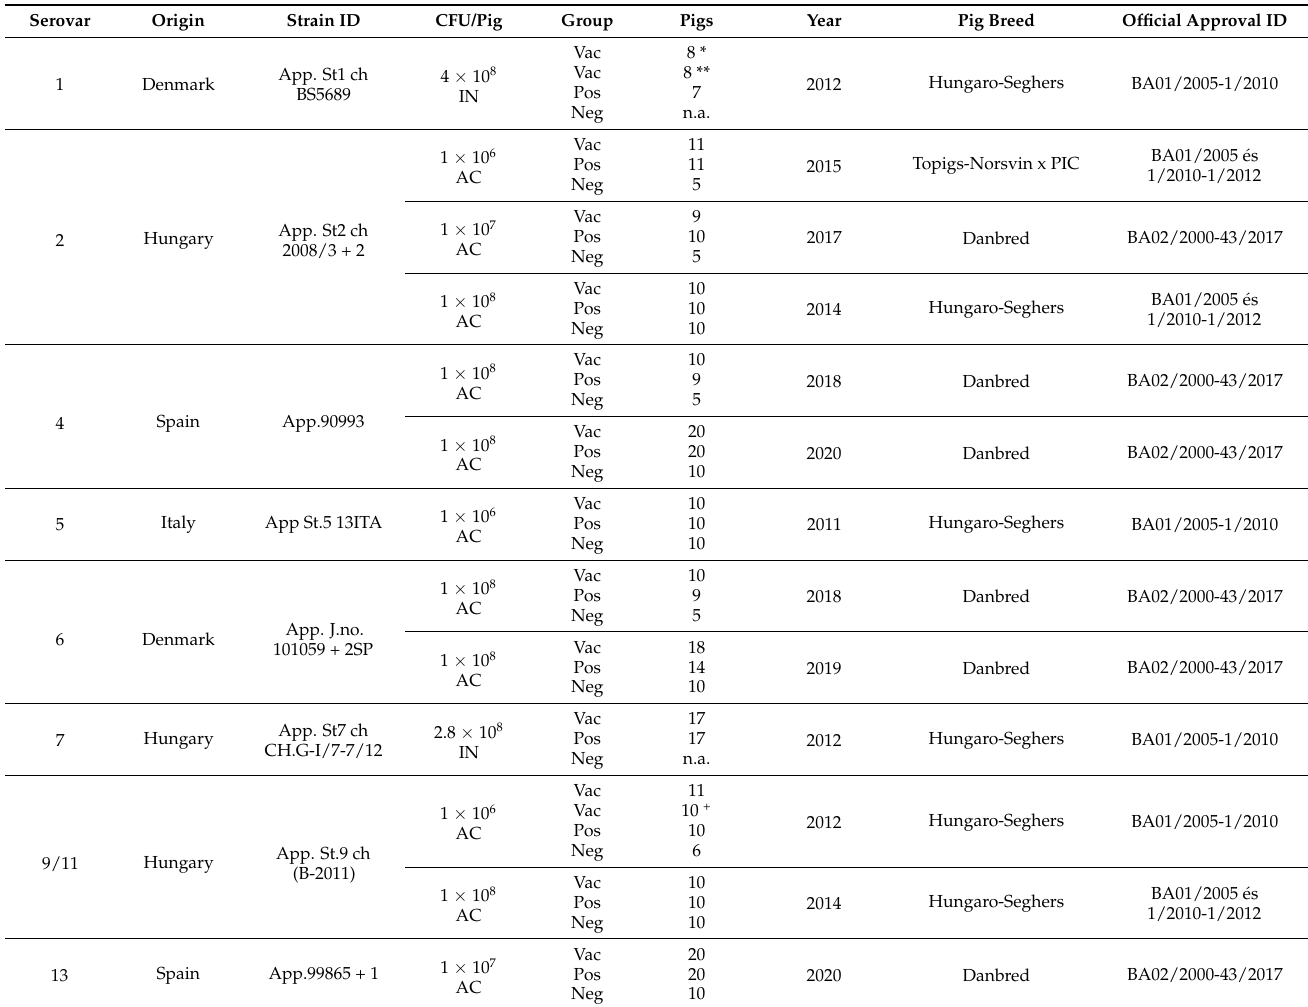
Table 1. List of A. pleuropneumoniae challenge trials used in in this analysis. Two studies performed by Ceva R & D are intranasal dosed challenges (IN) and the 11 studies performed by Ceva SSIU are all aerosol chamber dosed challenges